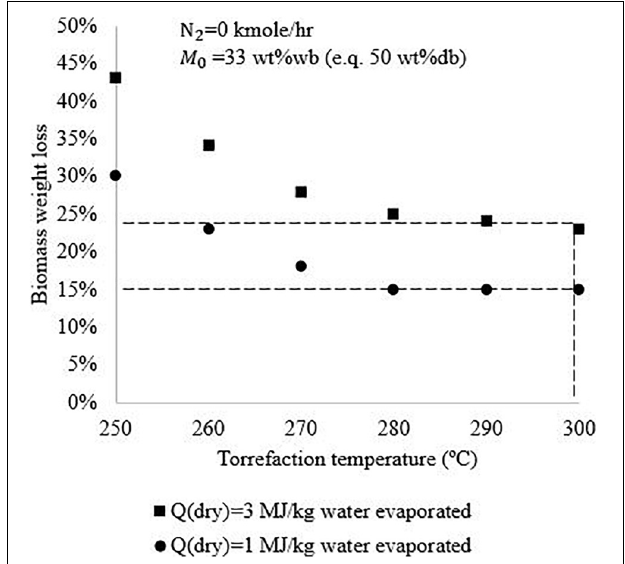
FIGURE 5 | Auto-thermal operation boundaries of biomass torrefaction process using conventional drying technology and advanced drying